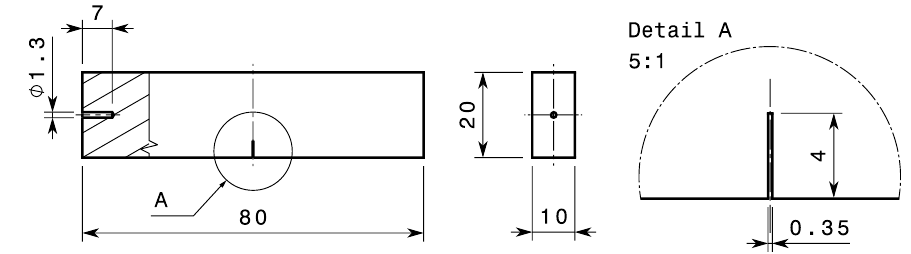
Figure 6. SENB geometry utilized for crack propagation experiments.